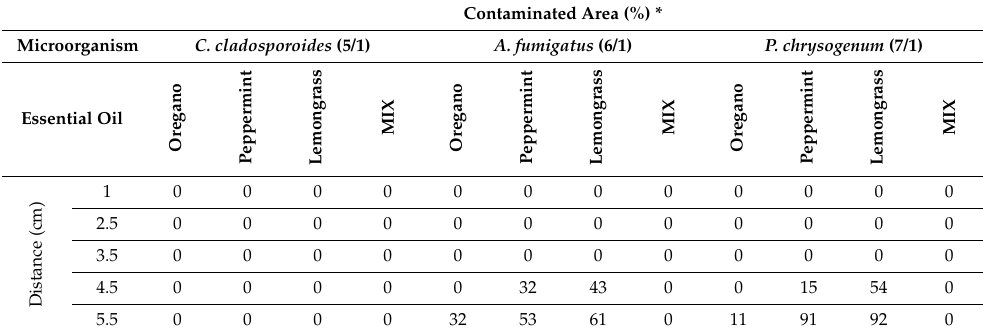
Table 6. Interpretation of data * for EOs efficiency in vapour phase based on contaminated surface